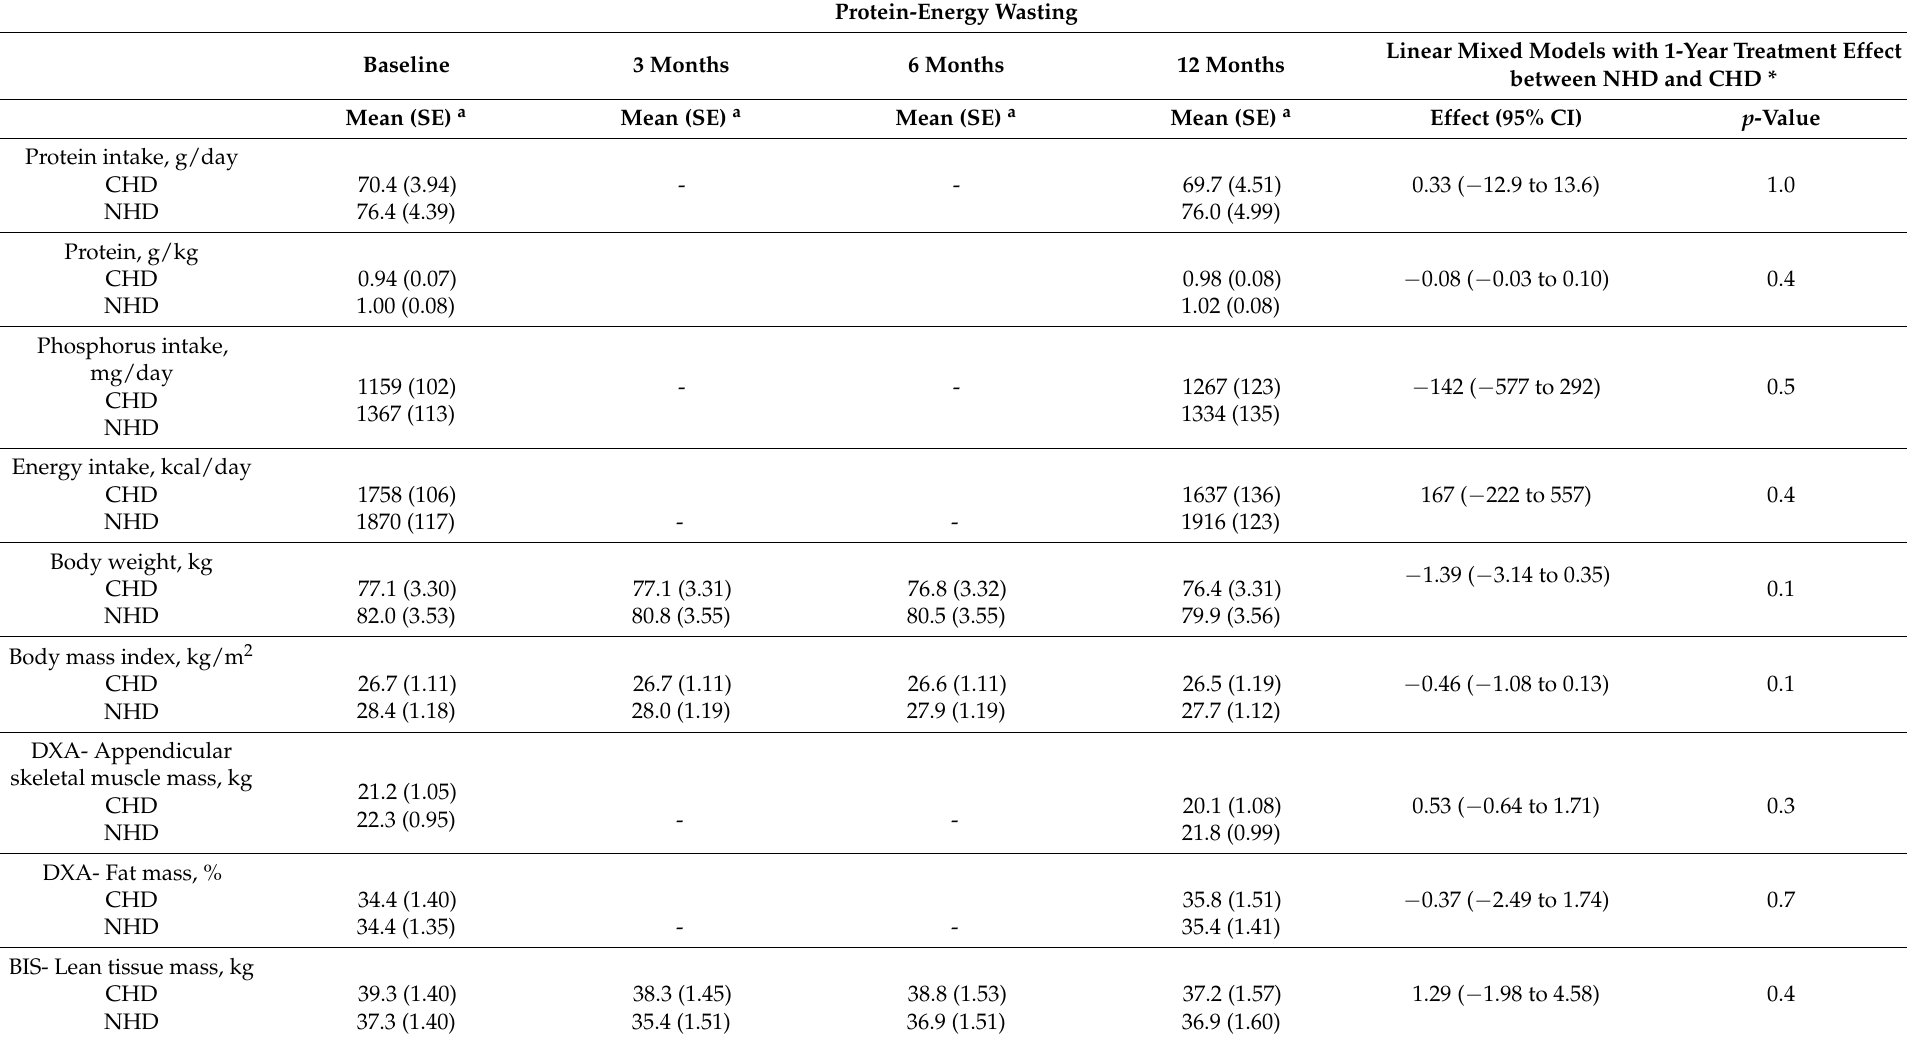
Table 4. Aspects of protein-energy wasting over 1-year in nocturnal hemodialysis patients compared to conventional hemodialysis